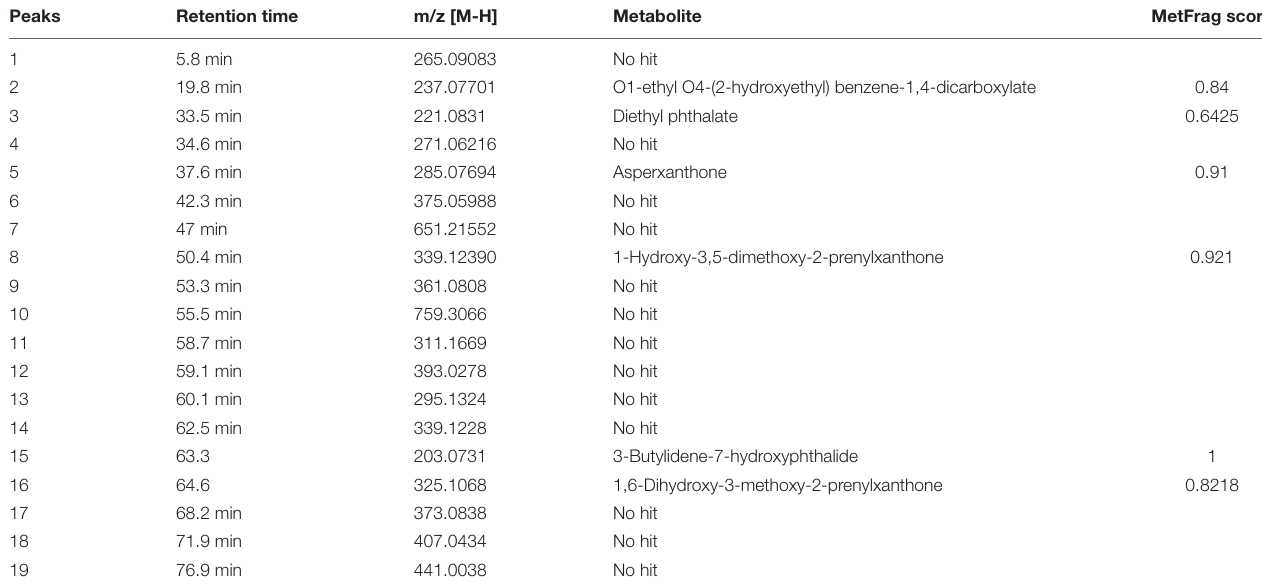
TABLE 3 | List of secondary metabolites in AUME with retention time and MetFrag score identified by LC-MS/MS analysis. Peaks Retention time m/z [M-H] Metabolite MetFrag